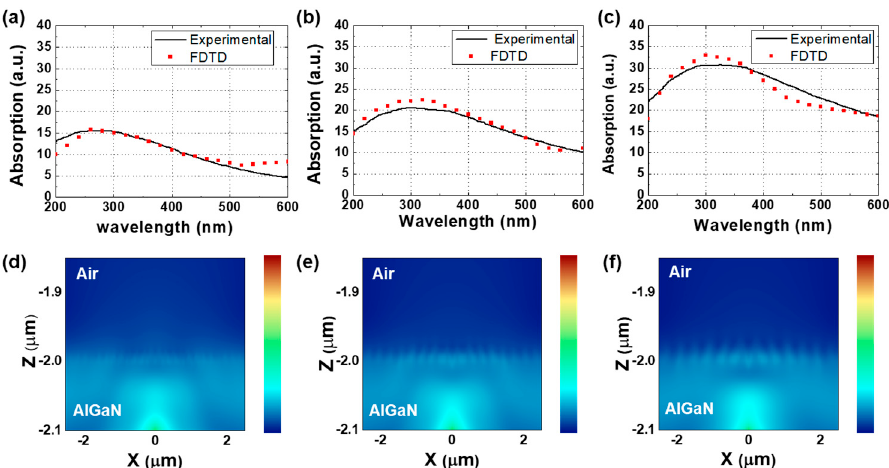
Figure 4. Finite-difference time-domain (FDTD) simulations according to the diameters of Pt NPs in UV emitters. Calculated and experimented absorption and field propagations according to the diameters of Pt NPs ( a , d ) 10 nm, ( b , e ) 20 nm, and ( c , f ) 25 nm, respectively.